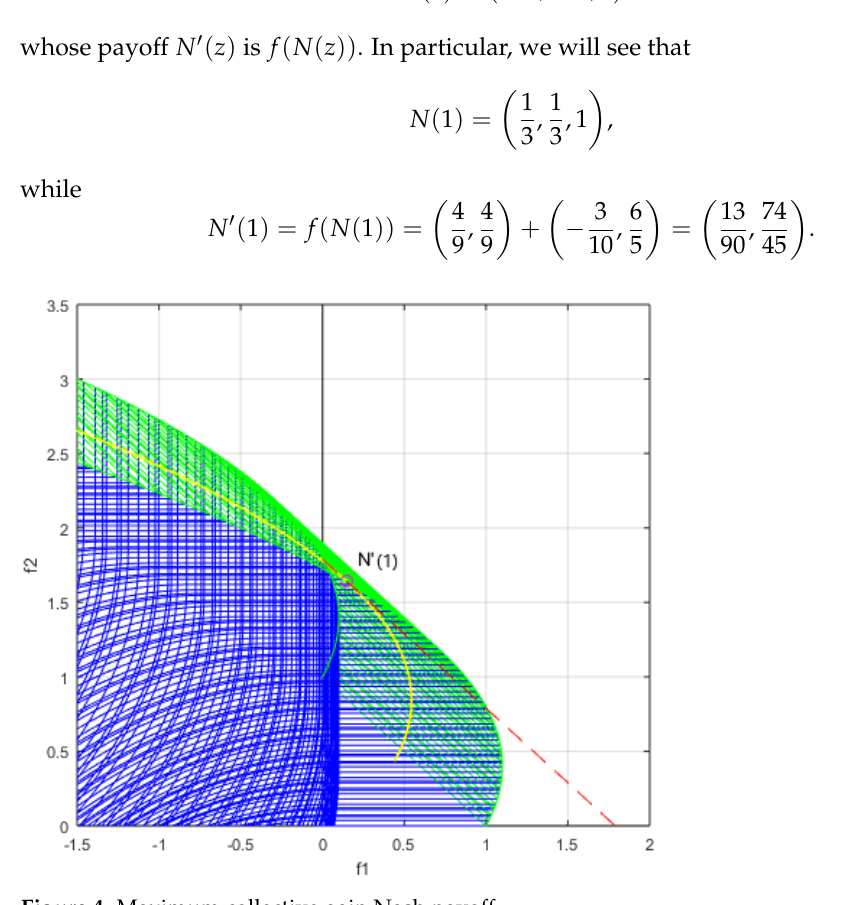
Figure 4. Maximum collective gain Nash